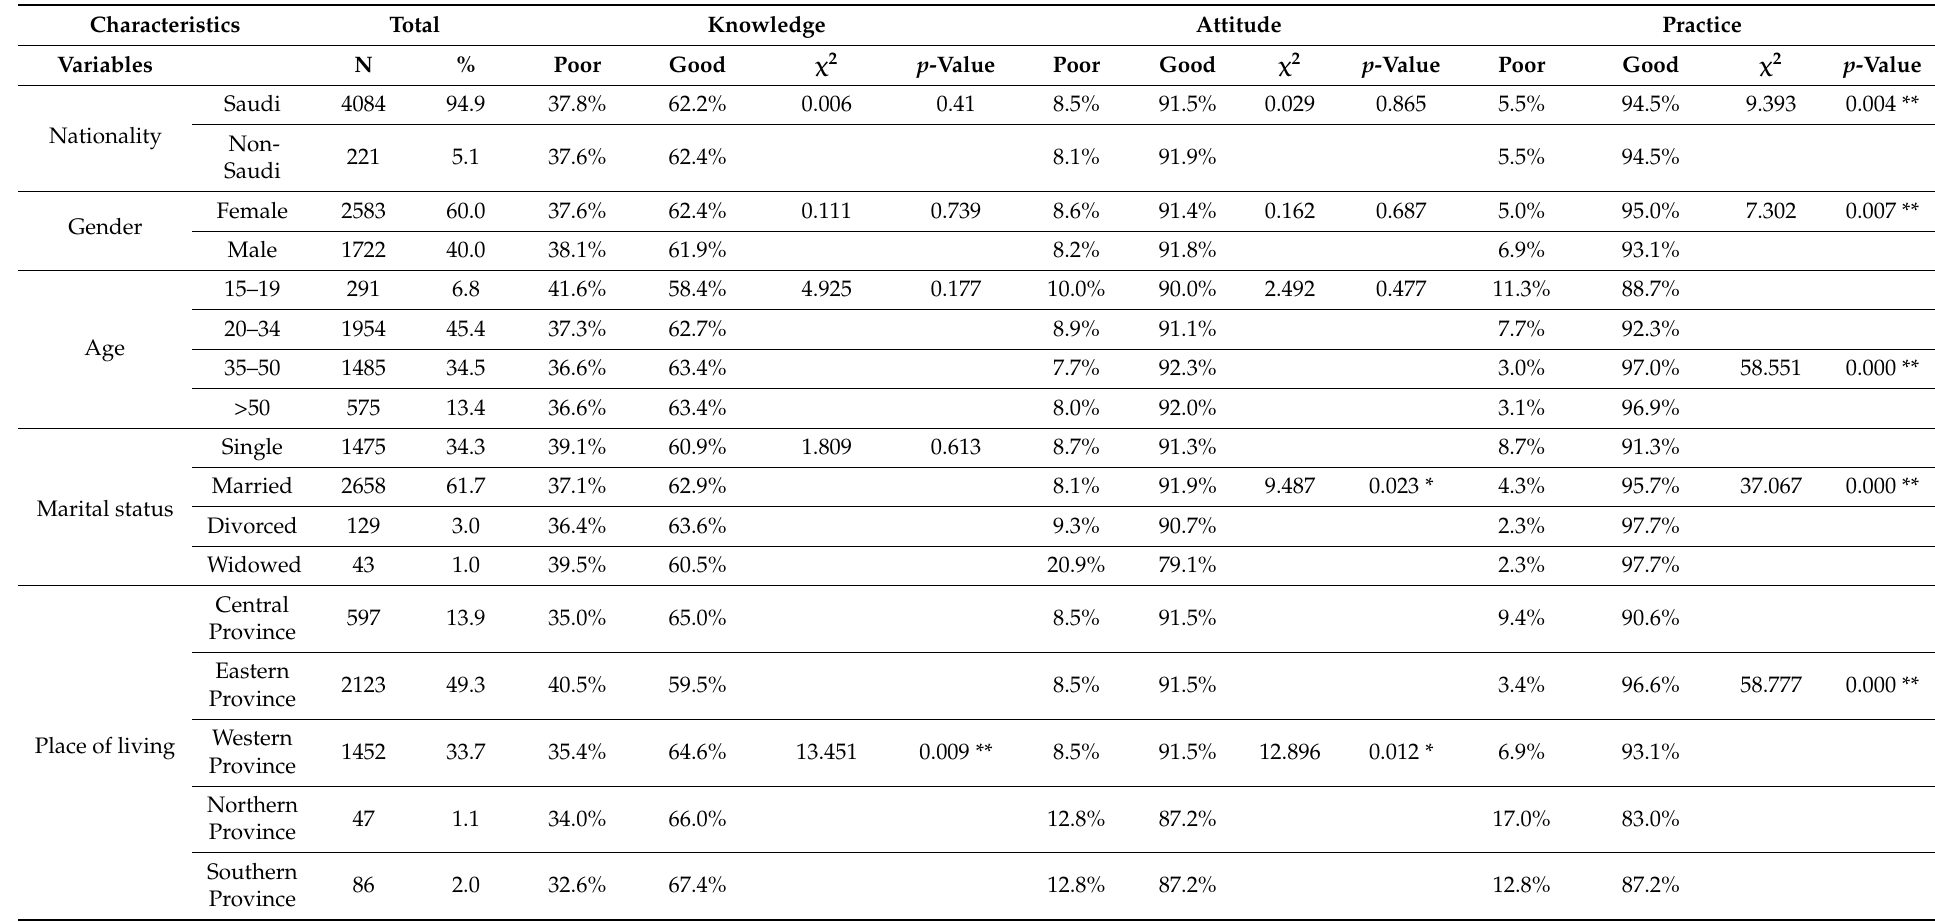
Table 1. Association between knowledge, attitudes, and practices (KAP) and sociodemographic characteristics of the COVID-19 pandemic.